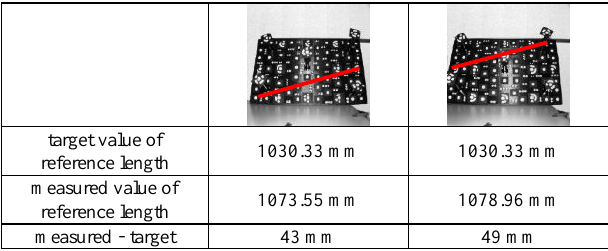
Table 5. Evaluation of exterior